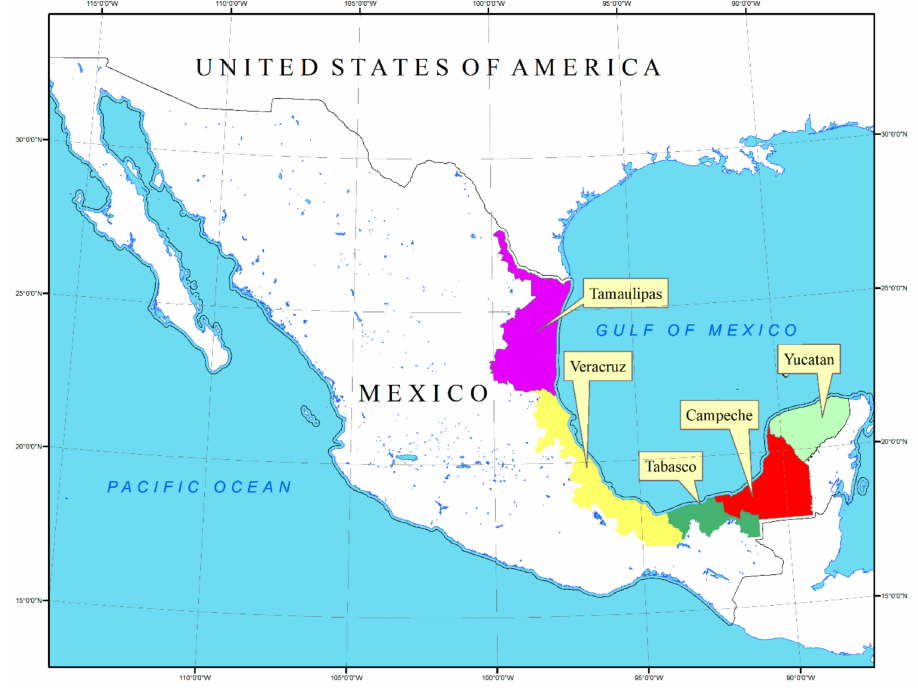
Figure 1. Mexican states along the Gulf of